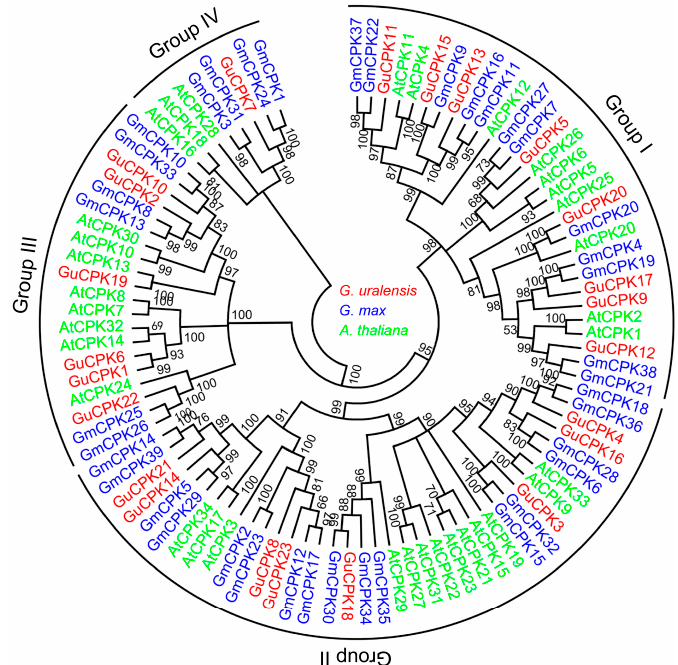
Figure 3. Phylogenetic relationship analysis of the CPK family. A total of 96 CPK proteins from G. uralensis (GuCPK), Arabidopsis (AtCPK) and G. max (GmCPK) were used to constructed a phylogenetic tree by ClustalX 2.0 and MEGA5.0 software with the neighbor-joining (NJ) method of 1000 bootstrap replicates. The CPK proteins of G. uralensis , Arabidopsis , and G. max were shown in red, green, and blue, respectively. Molecules 2019 , 24 , x FOR PEER REVIEW